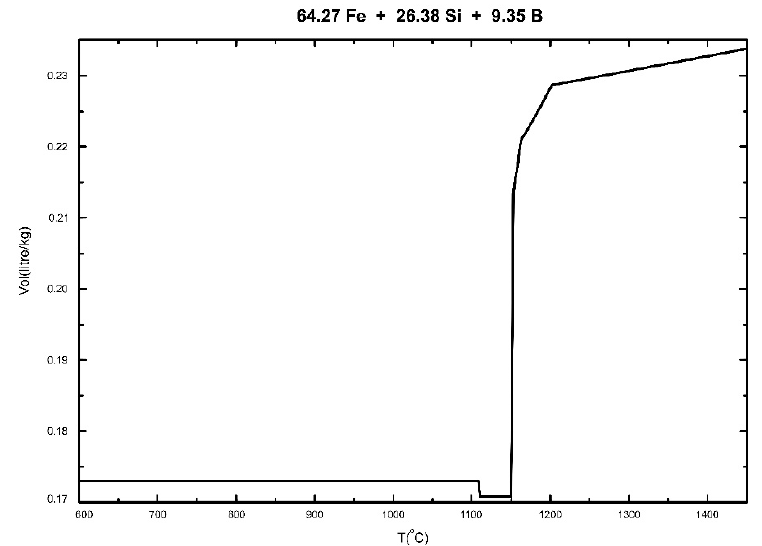
Figure 19. Calculated volume evolution of Fe-26.38Si-9.35B alloy with the decrease of temperature from 1450 °C to 600 °C.